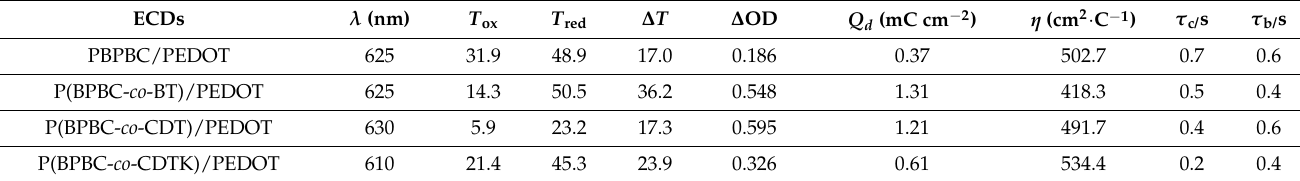
Table 6. Optical and electrochromic switching properties investigated at selected wavelengths for the devices.